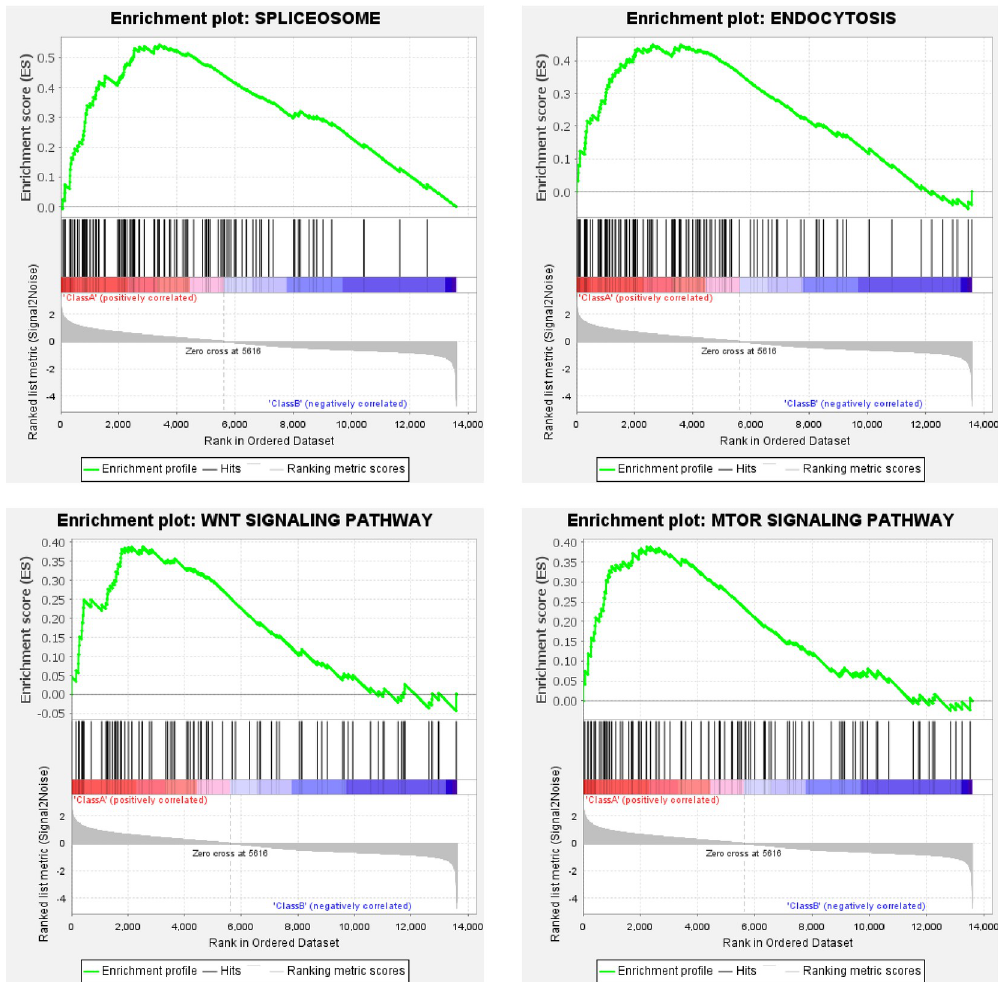
Fig 4. Representative KEGG enrichment plots of the ELAV group. For each plot, the upper part shows the enrichment score; while the lower part shows ranked list metric of the gene set. The middle part shows the ranked gene list, with red meaning upregulation, blue for downregulation, and black vertical line for the genes of the